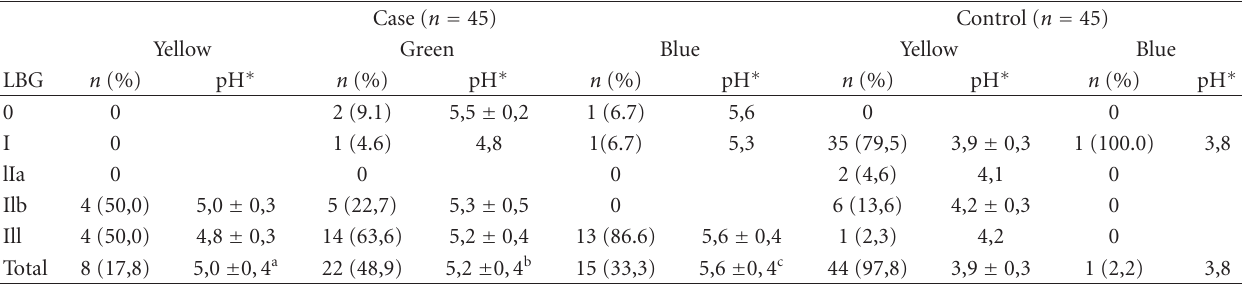
Table 5: VS-SENSE test and vaginal pH values according to the lactobacillary grade (LBG) determined by microscopic evaluation of fresh vaginal smears. Di ff erences according to Kruscal-wallis test.